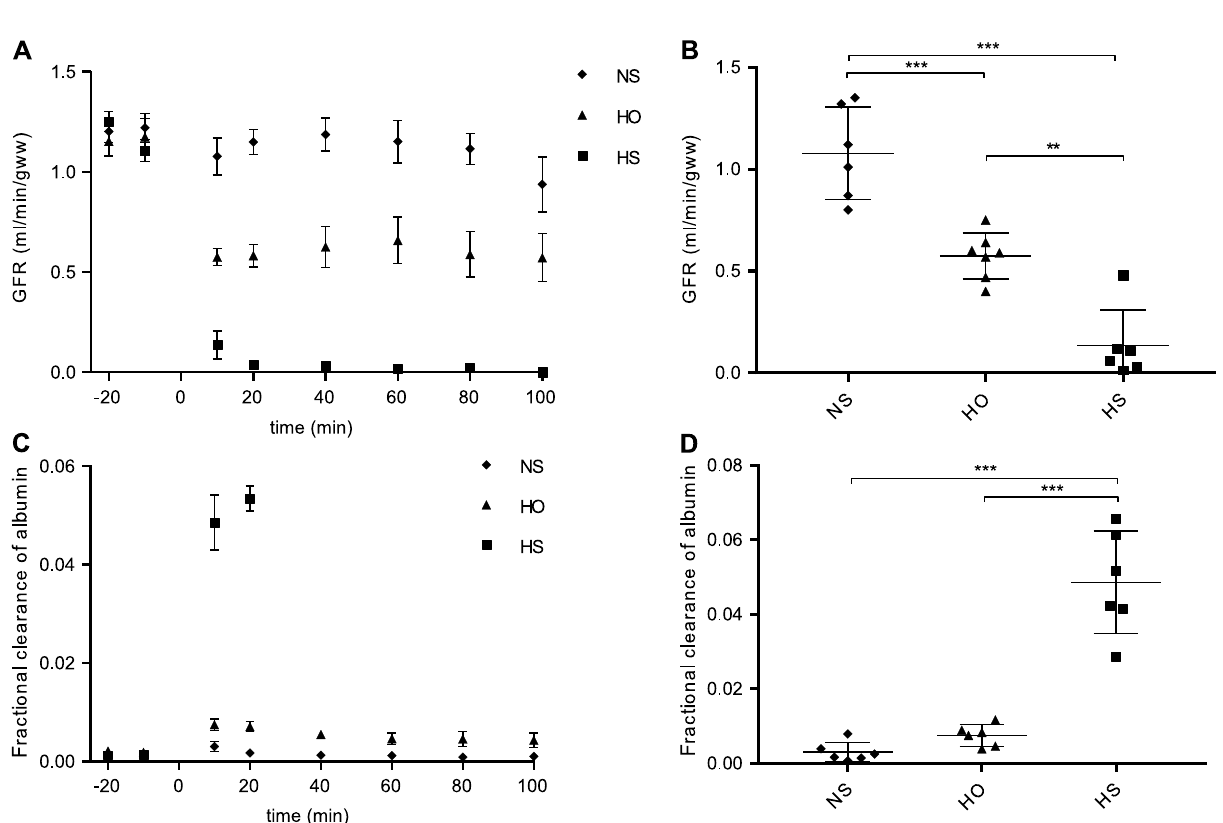
Figure 2. Glomerular filtration rate (GFR) and fractional clearance of albumin. Differences in GFR over time for three different groups of rats that were perfused for 3 min with physiological salt solution (NS), high osmolarity control (HO) and high salt (HS), respectively ( A ). 10 min after the perfusion the GFR had decreased to around half of the GFR at the start of the experiment in the rats perfused with HO, and even further in the rats perfused with HS ( B ). Fractional clearance for the three different groups over time. 40 min after perfusion with HS the rats became anuric ( C ). 10 min after the perfusion the fractional clearance of albumin was increase in the rats perfused with HS, but not in the rats perfused with HO or NS ( D ). **P < 0.01, ***P < 0.001, error bars represent